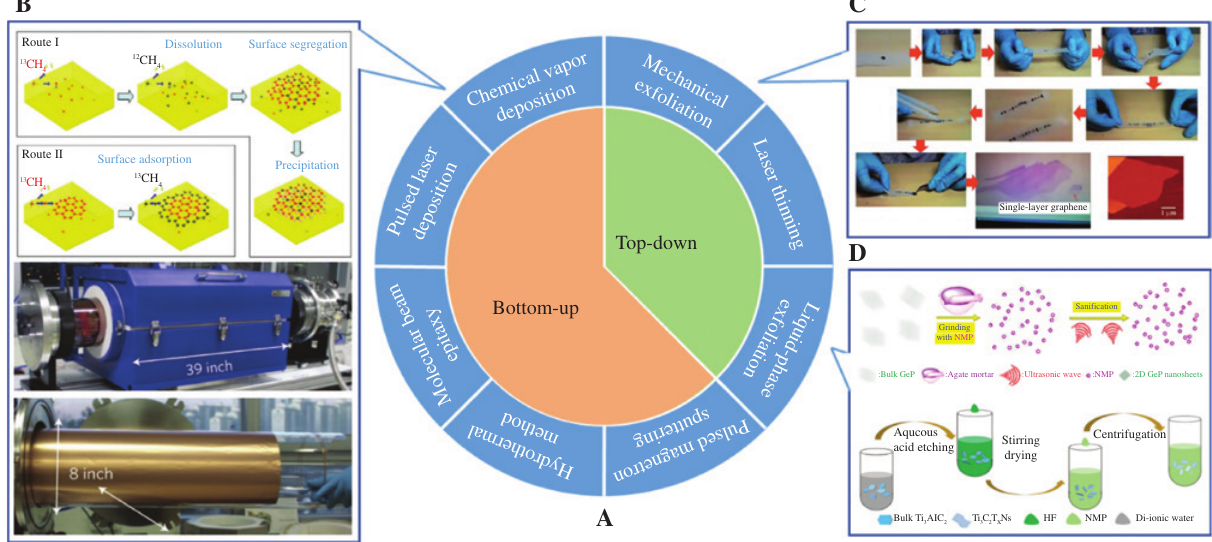
Figure 3: Fabrication methods of 2D materials.